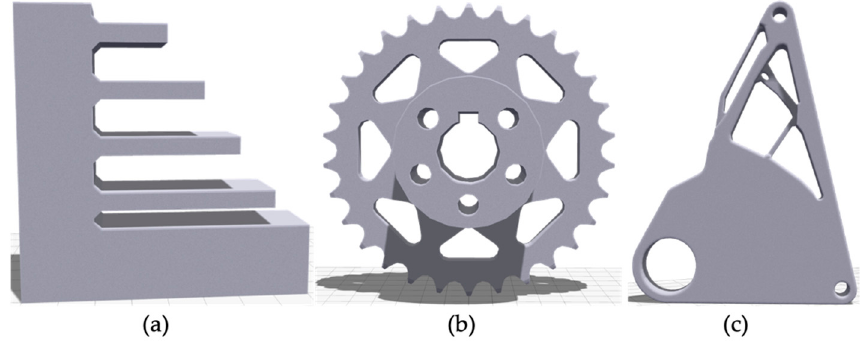
Figure 5. Example parts selected for testing the automated simulation framework before scaling. ( a ) staircase; ( b ) sprocket; ( c ) topology optimized chassis diverter.